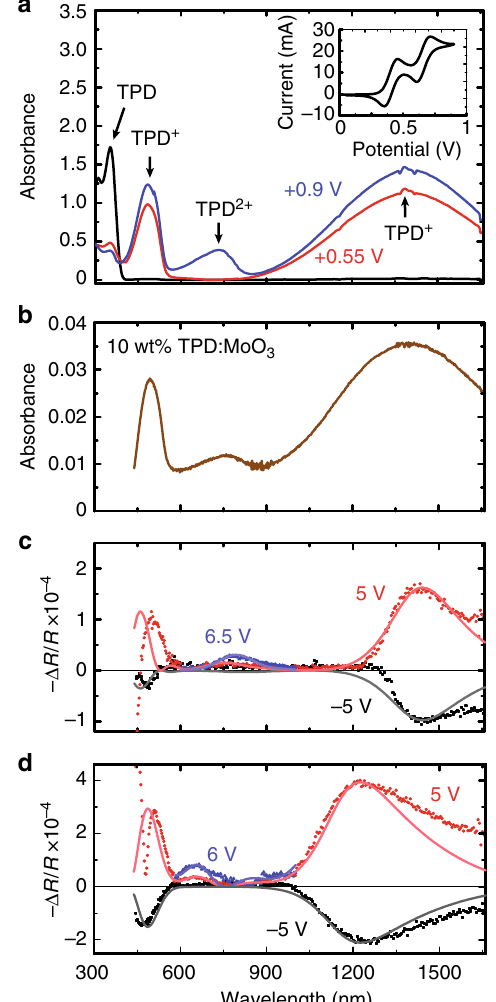
Fig. 1 Polaron and bipolaron spectroscopy. a Absorption spectra of the TPD cation and dication in solution. The solution consists of 55 μ M TPD dissolved in dichloromethane with a 0.5M tetrabutylammonium tetra fl uoroborate electrolyte. Electrochemically oxidizing the initially clear solution (black line) for 1h at 0.55V with respect to a Ag/Ag + reference electrode causes it to turn orange due to the formation of TPD cations that absorb in the blue and near-infrared (red line). Further oxidizing the solution at 0.9V for 2h (blue line) causes it to turn dark green due to a new absorption band at λ = 734 nm originating from TPD dications. The cyclic voltammetry scan in the inset ¼ 0 : 45 V and E 2 þ ¼ 0 : 71 V, yields fi rst and second oxidation potentials E þ 1 = 2 1 = 2 respectively. b Absorption coef fi cient of a 50nm thick fi lm of TPD thermally co-evaporated with 10wt% MoO 3 . c Charge modulation difference spectra recorded for an ITO (100nm)/TPD (250nm)/Ag (100nm) hole-only device pulsed at − 5V reverse bias (black data points) and 5V forward bias (red data points) using s-polarized light incident at a 45 (cid:2) angle. Increasing the voltage to 6.5V (blue data points) con fi rms the emergence of the bipolaron absorption band at λ ~ 780 nm. d Similar data for a 200 nm thick device, demonstrating the optical interference-induced spectral shift that occurs for the polaron and bipolaron absorption bands. The solid lines in ( c , d ) are produced by a transfer matrix optical model based on the polaron and bipolaron lineshapes in ( b ) under the assumption that both species are located in a 1nm thick layer adjacent to the ITO